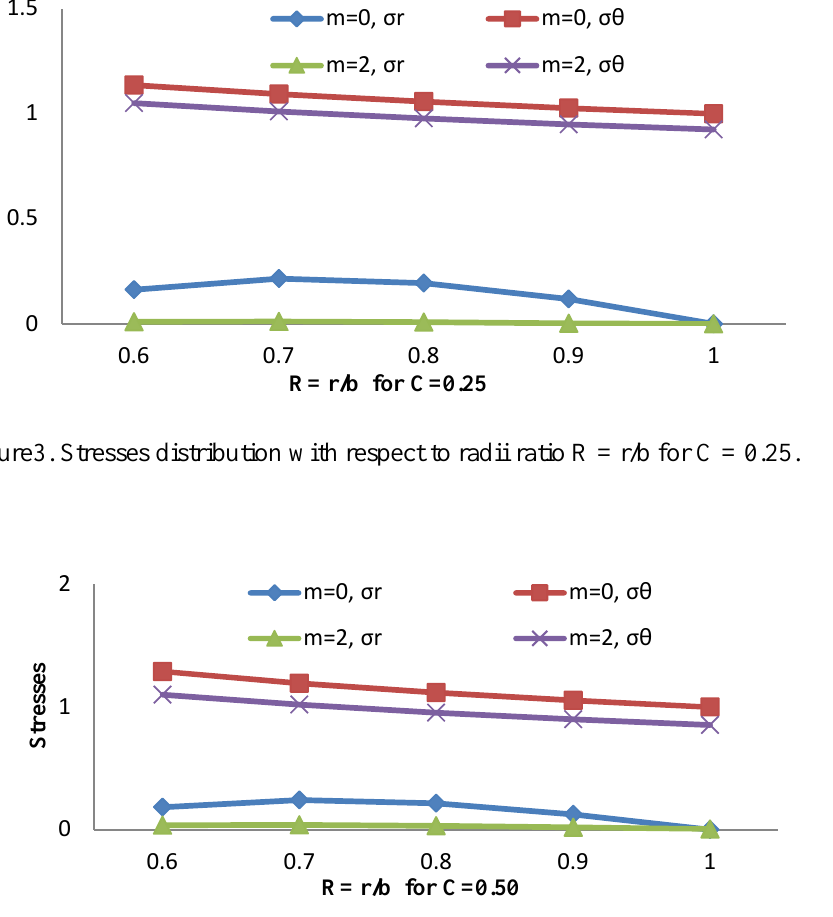
Figure4. Stress distribution with respect to radii ratio R = r/b for C = 0.5.